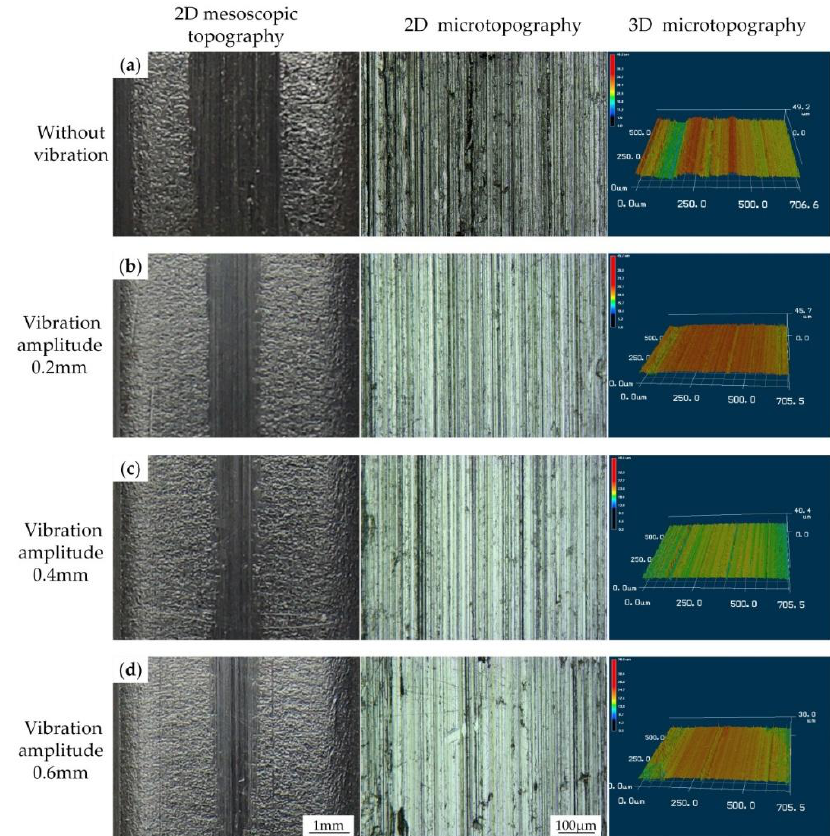
Figure 11. Comparison of the surface quality of clutch hubs formed under different vibration amplitudes: ( a ) Without vibration; ( b ) With vibration at frequency 30 Hz; ( c ) With vibration at frequency 20 Hz; ( d ) With vibration at frequency 10 Hz